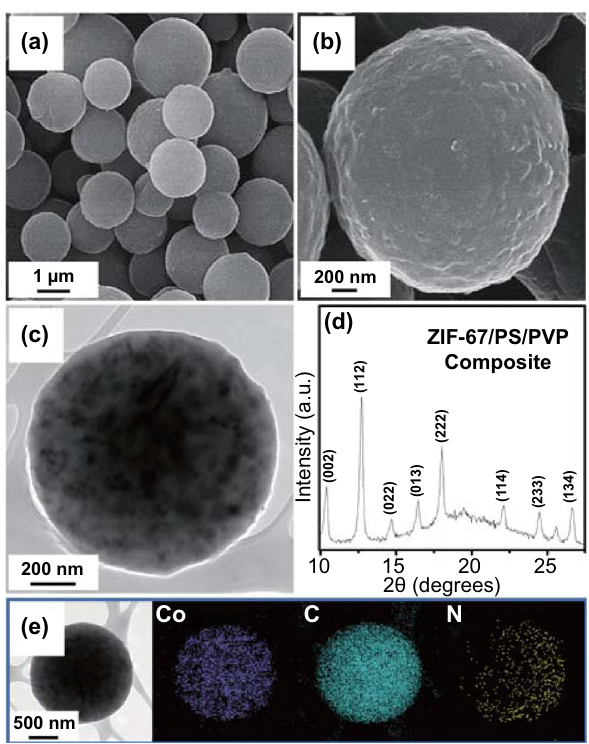
Fig. 1 a , b FE-SEM images, c TEM image, d XRD pattern, and e elemental mapping images of the ZIF-67/PS/PVP composite micro- spheres obtained after spray pyrolysis at 400